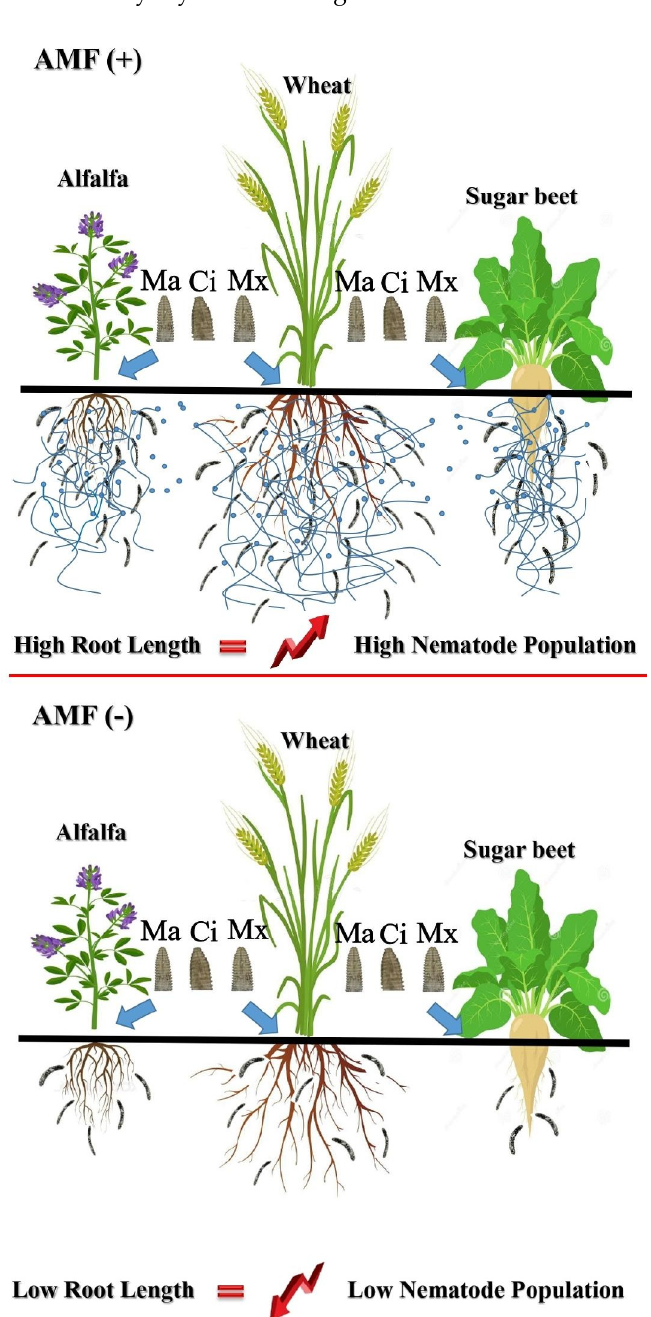
Figure 6. Schematic representation of the results obtained from the arbuscular mycorrhizal fungi (AMF) and nematode species inoculation treatments on the root length of three host plants (Ma = M. antipolitanum ; Mx = M. xenoplax ; and Ci = C. informis ) (Figure by Boyno, G.).